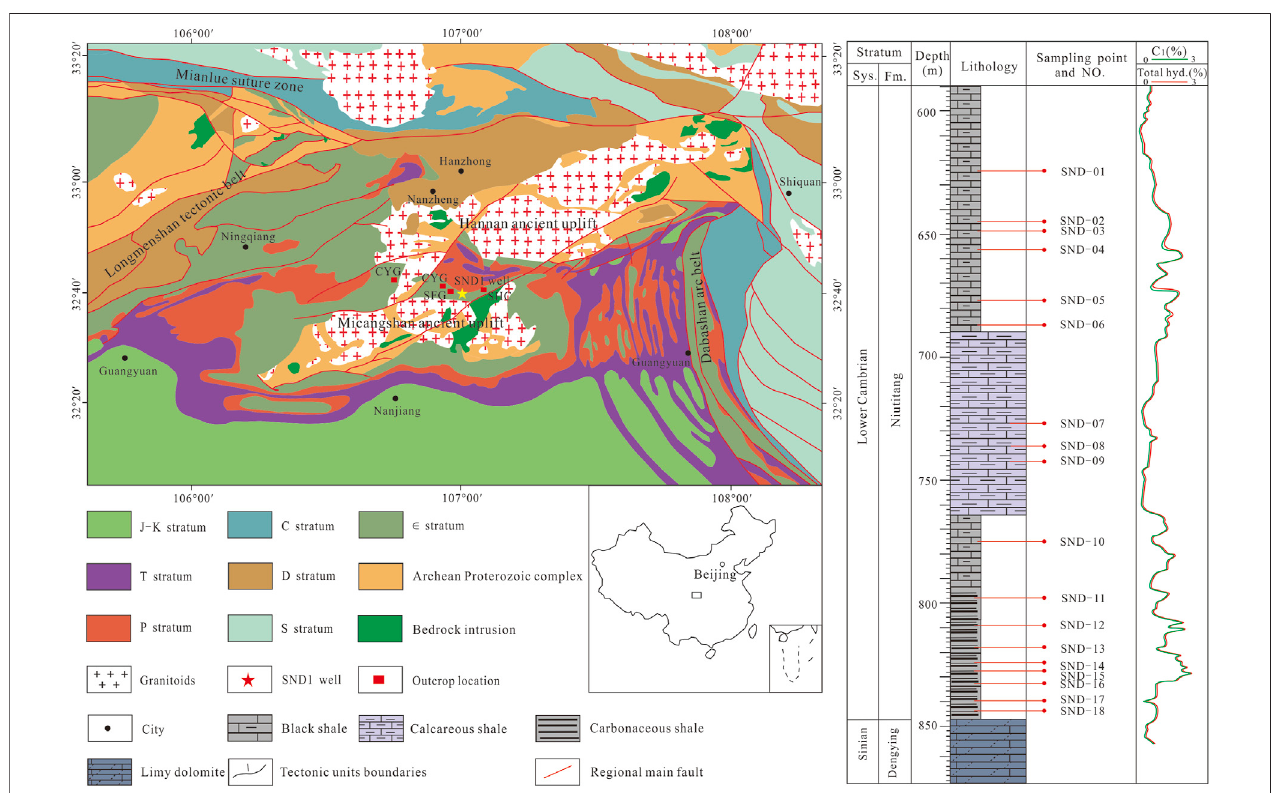
FIGURE 1 | Geological map of the study area and stratigraphic column of the Niutitang Formation (Fm.) of SND1 well and sampling positions. Sys, system; Total hyd, total hydrocarbon.